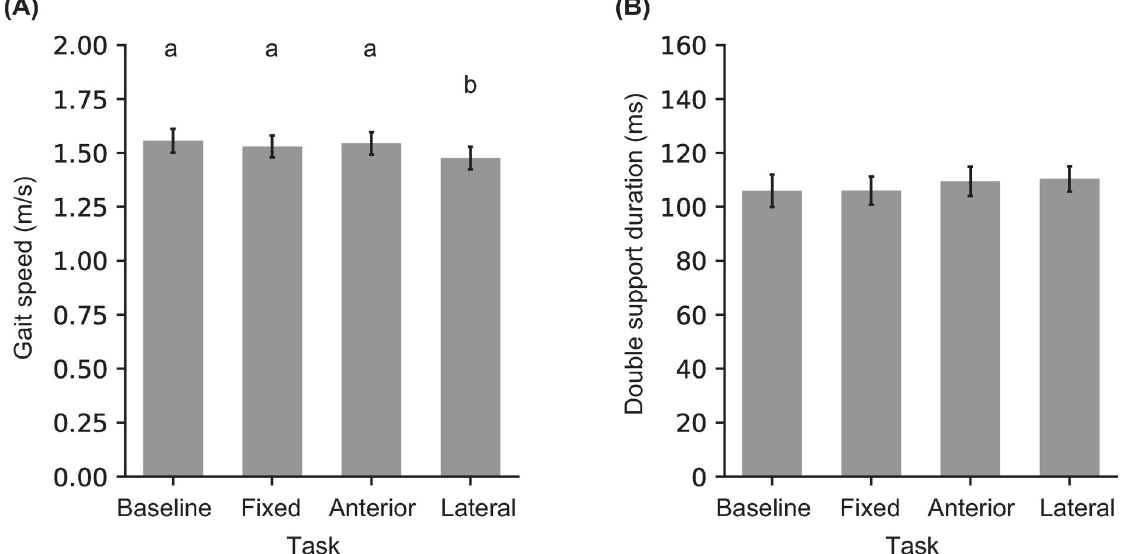
Fig 3. (A) Mean and standard error for gait speed during double support phase, and (B) double support duration for the four tasks. Means with different letters are significantly different from one